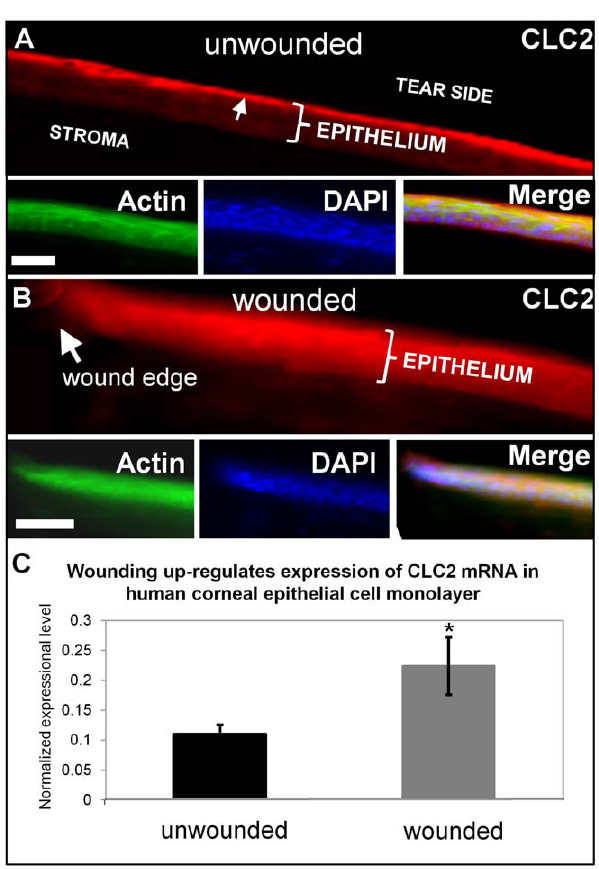
Figure 8. Distribution and expression of calcium-activated chloride channel-2 (CLC2). A. In unwounded cornea, CLC2 channels were concentrated in the superficial epithelial cells (arrow). B. One hour after wounding, fluorescence was present throughout the entire thickness of the epithelium, showing re-distribution and increased concentration of CLC2 channels. Scale bars 50 m m. C. In human corneal epithelial cell monolayer, scratch wounding induced increased expres- sion of CLC2 channel mRNA (*P , 0.05).